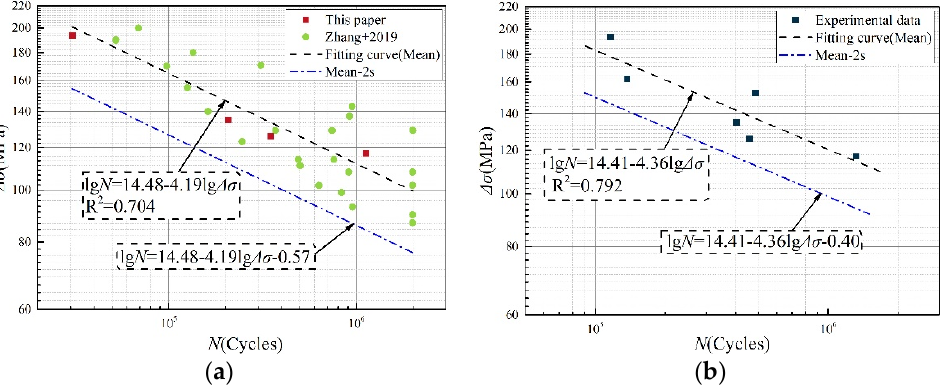
Figure 15. Double-logarithmic S-N curve fitting with ∆ σ as variable. ( a ) Unreinforced specimen ( b ) Strengthened with CFRP.